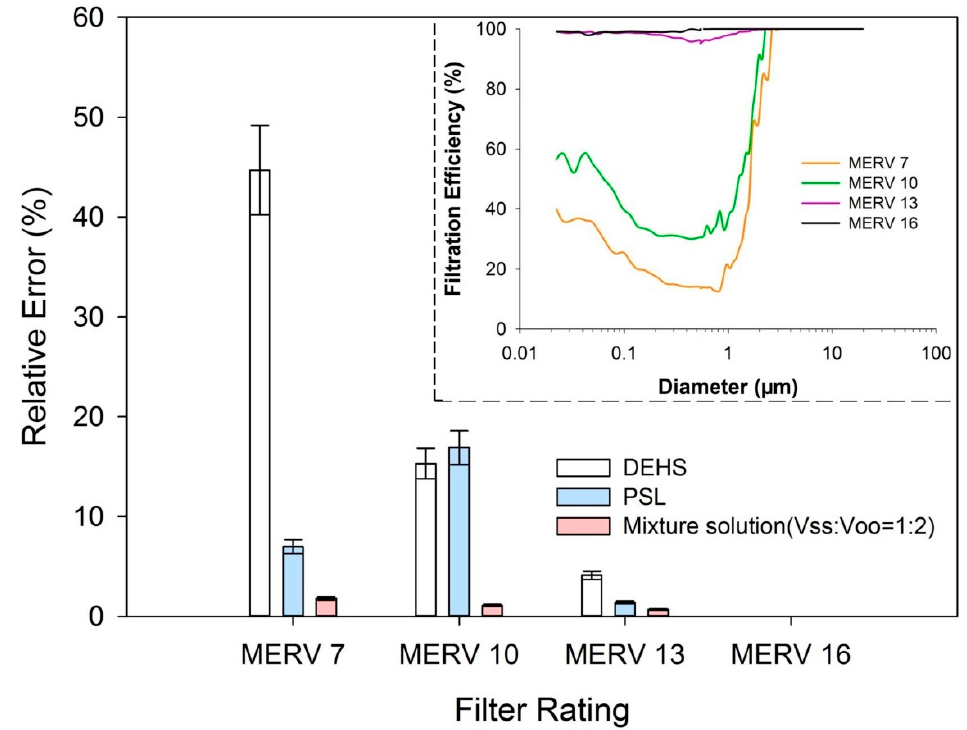
Figure 6. Relative error of mass-based filtration efficiency for PM 2.5 measured with experimental aerosols and atmospheric aerosol.